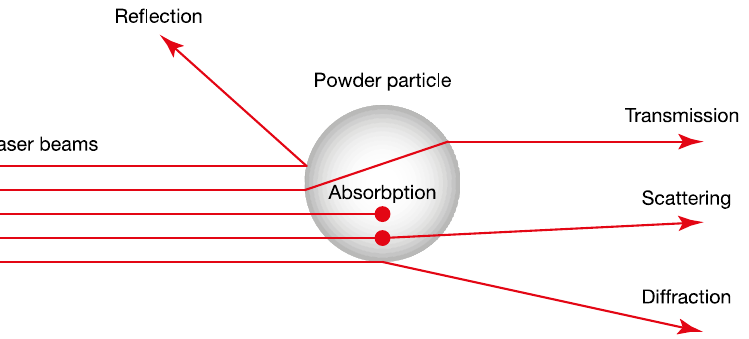
Figure 14. Illustration of the effects occurring during the laser-powder interaction.